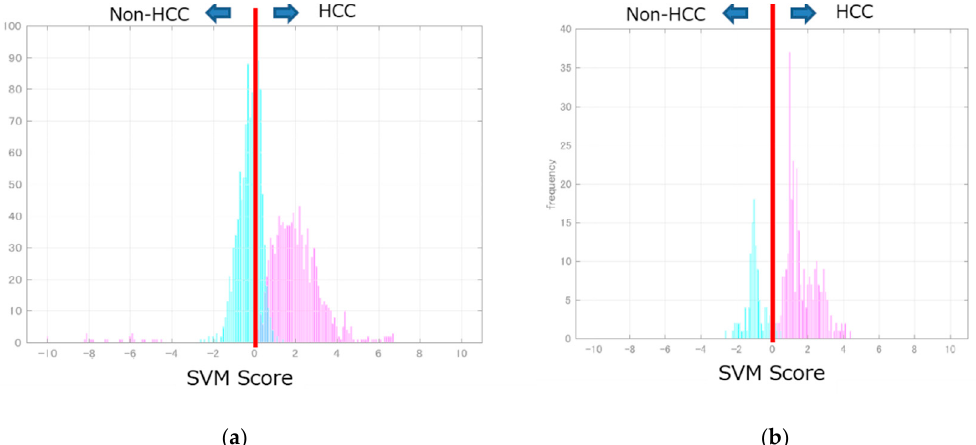
Figure 3. Support Vector Machine score distribution of non-HCC specimens (blue) and HCC specimens (pink). ( a ) Analysis of Italian samples (2529 spectra, 180 specimens) using the SVM database built with Japanese samples; ( b ) Analysis of Italian samples (30 samples as Test datasets) using a database built only with Japanese samples (7786 spectra) and with Italian samples (2529 spectra).